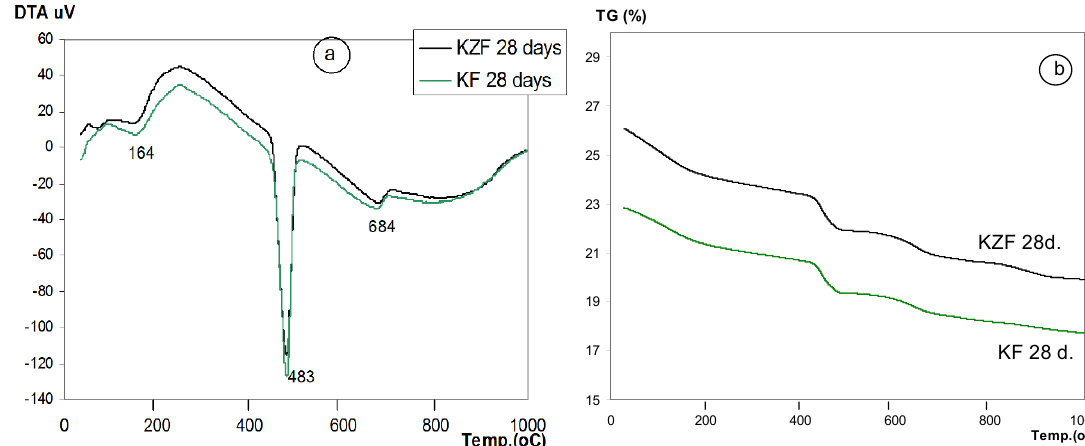
Figure 10. DTA (a) and TG (b) curves of KZF and KF pastes hydrated 28 days.